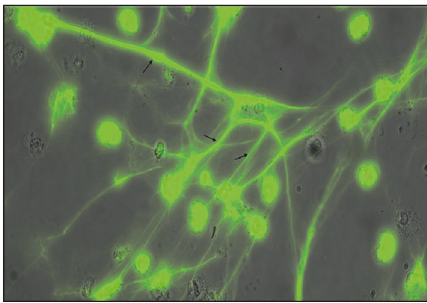
Figure 1: Fluorescent microscopy image of NETs (marked with arrows) following incubation with 25 𝜇 l PMA (1mg/ml [1: 800 then 1: 10